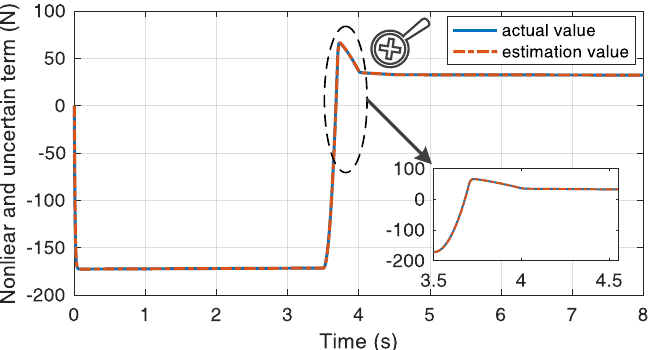
Figure 10. Estimation result for carriage 2 with the designed disturbance observer in case